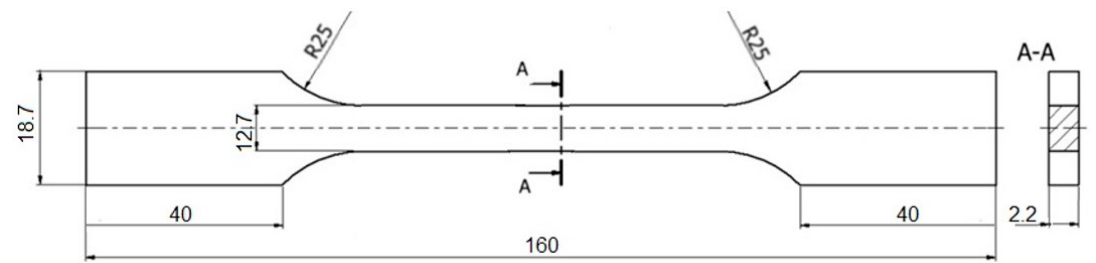
Figure 2. Shape and dimensions of specimens, dimensions in mm.